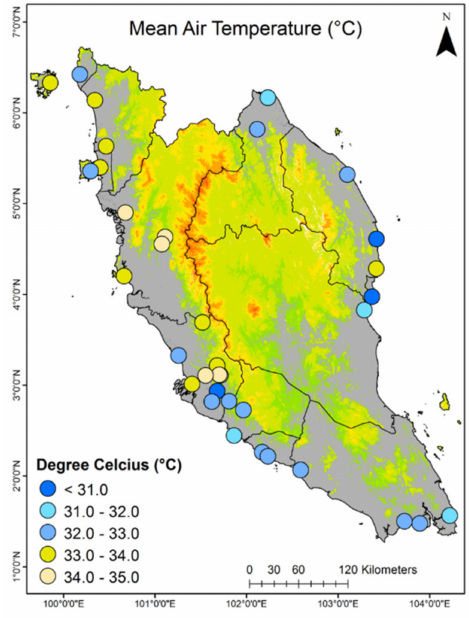
Figure 2. Map of mean T a distribution from 2003 to